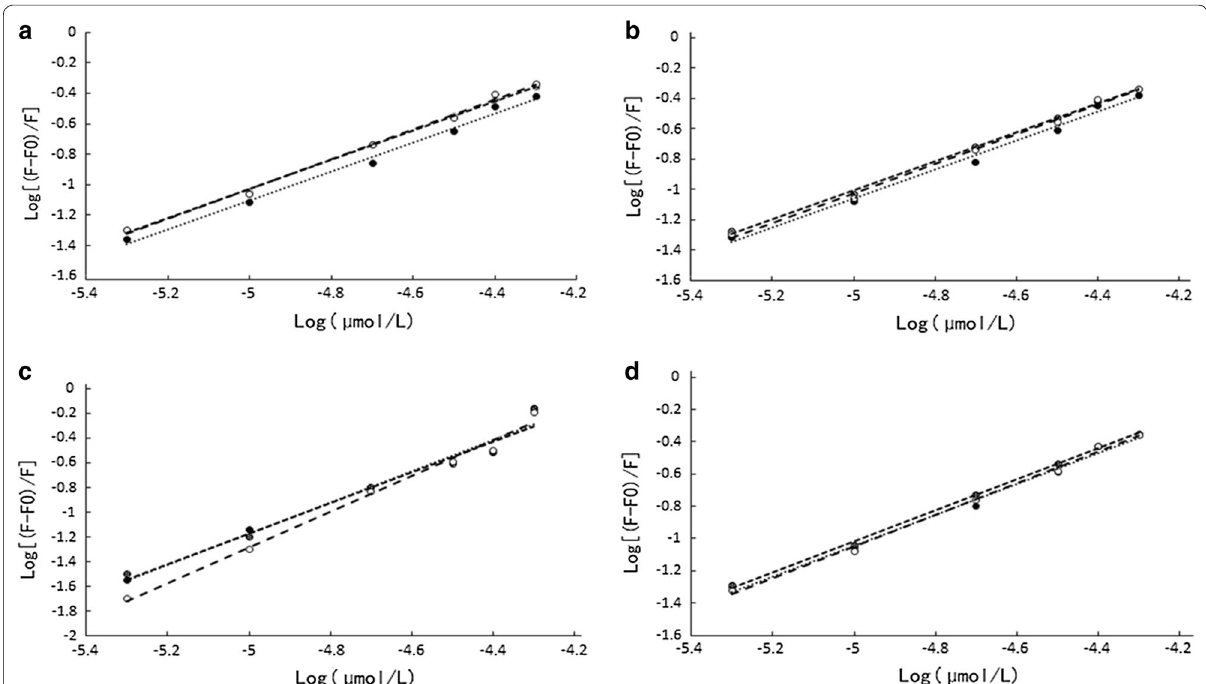
F)/F] versus log [c q ] of Cyanidin-3- O -arabinoside ( a ), Cyanidin-3- O -galactoside ( b ), −